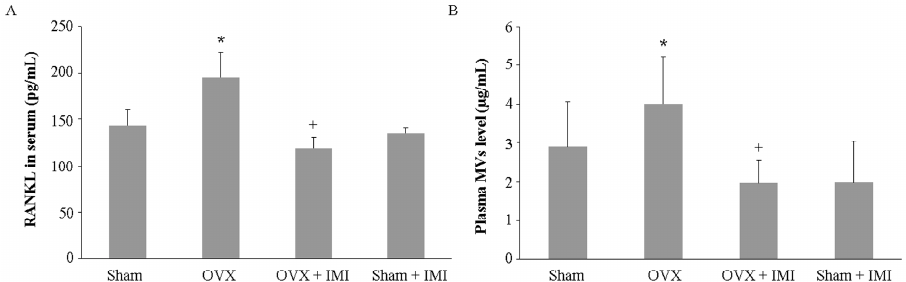
Figure 8. ( A ) Imipramine reduced serum levels of RANKL.Serum RANKL levels were measured by the ELISA method. Each bar represents the means ± standard deviation of eight mice; ( B ) Imipramine reduced plasma levels of MVs. Plasma levels of MVs were determined by measuring MV-associated proteins and are presented as micrograms of MV per milliliter of plasma. Statistical significance determined by two-way ANOVA is designated as follows: * p < 0.05 versus sham group; + p < 0.05 versus OVX group.